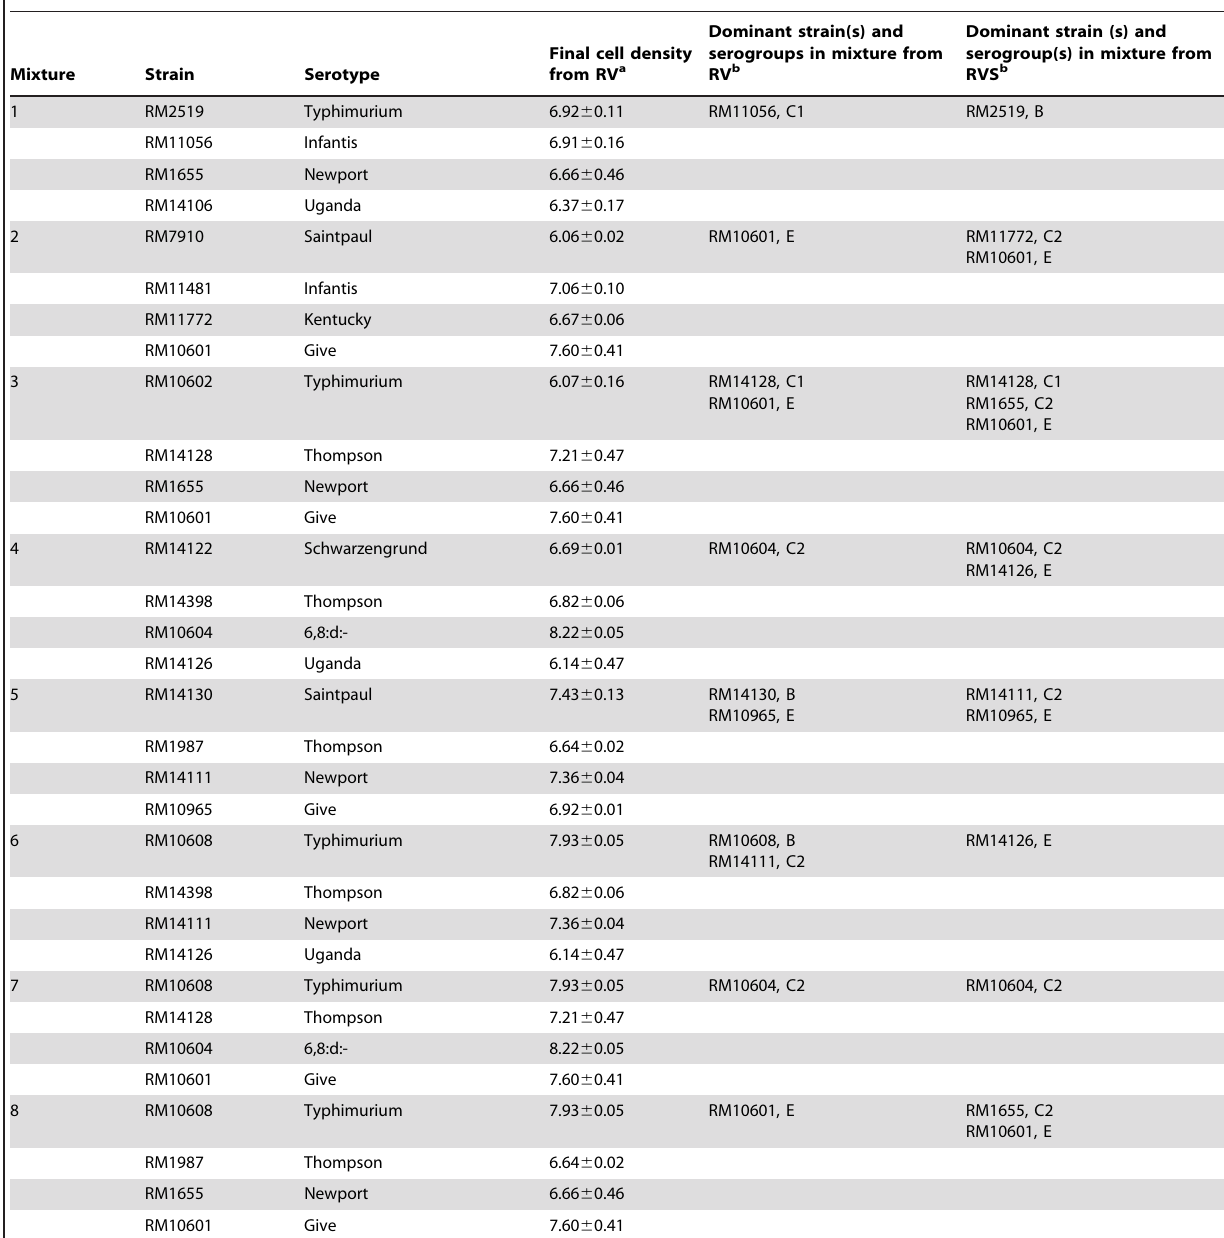
Table 2. Dominant strains from RV and RVS cultures after enrichment process.